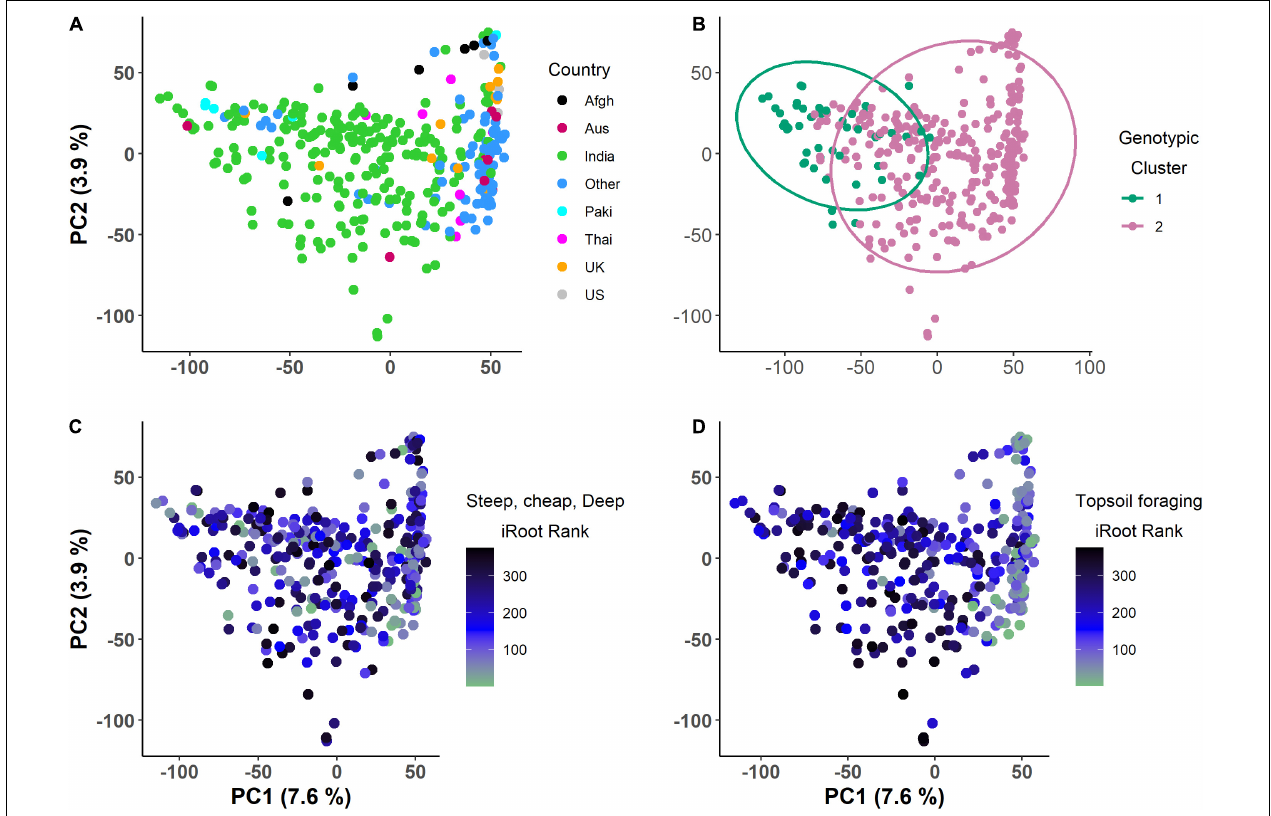
FIGURE 6 | Day 15 principal component analysis of the genotypes for the IA mung bean panel, (A) colored by country of origin, (B) colored by genotypic clusters, (C) color gradient showing ranking in the steep, cheap, and deep iRoot category, and (D) color gradient showing ranking in the topsoil foraging iRoot category (the lower the rank, the better the